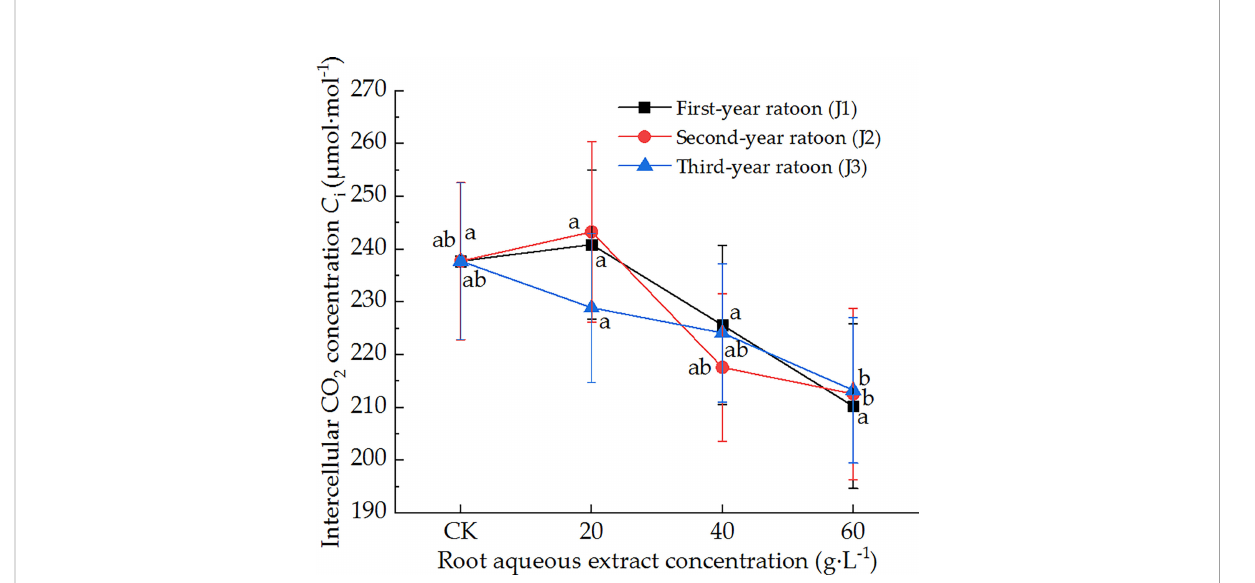
FIGURE 3 Response of C i in sugarcane seedlings to different root aqueous extracts. Different lowercase letters represent signi fi cant differences at the 5% level between different concentrations of root aqueous extract with the same ratoon